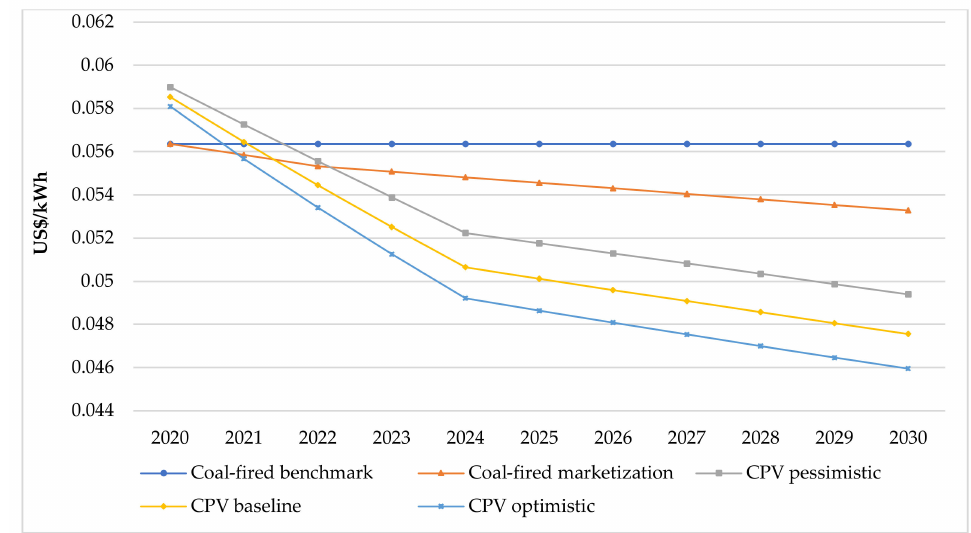
Figure 10. Cost comparison under Scenario